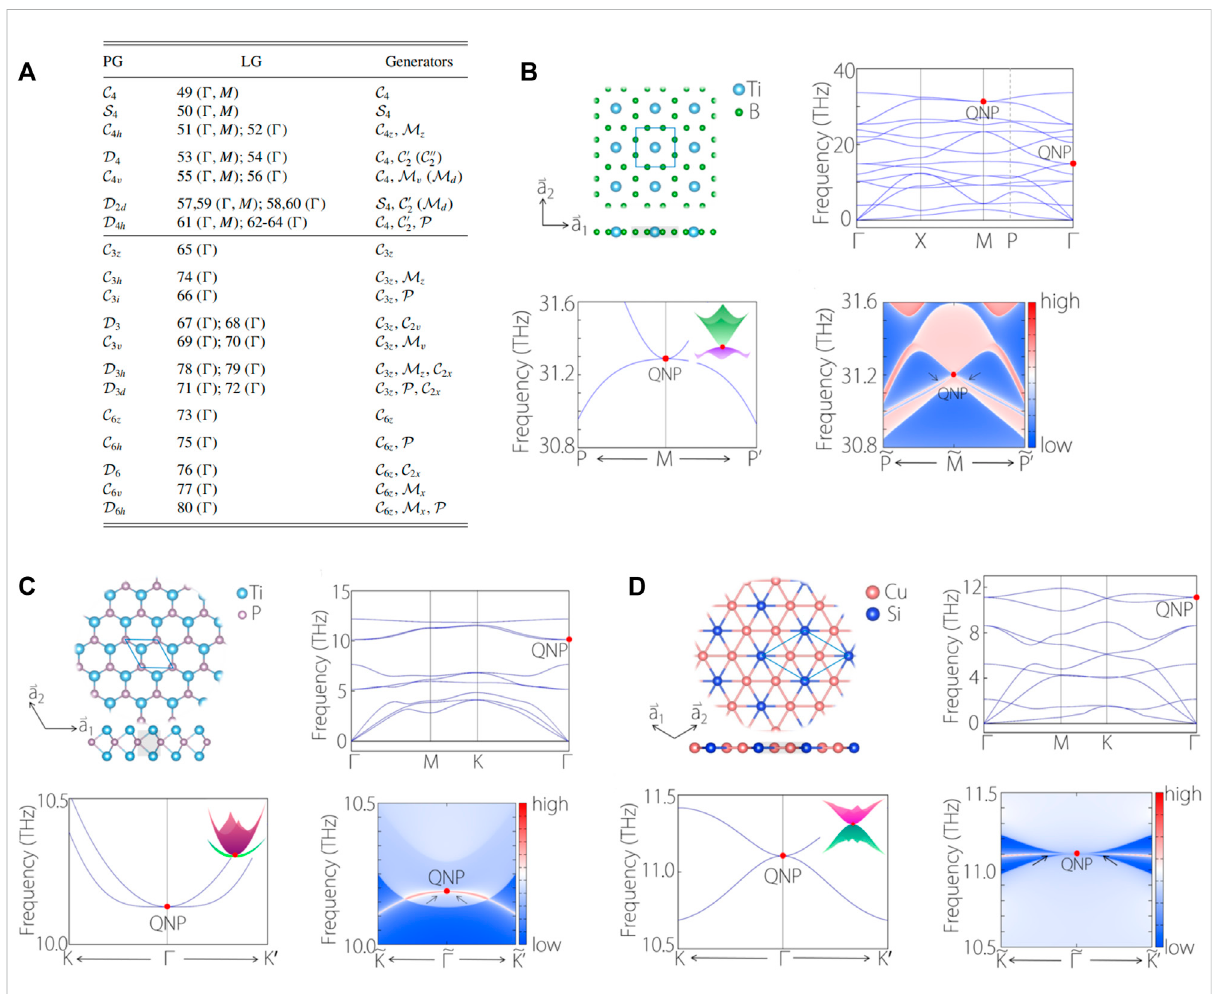
FIGURE 2 (A) ListsofPG,LG,andGeneratorsrelatedtothephononicquadraticnodalpointsathigh-symmetrypoints. (B – D)